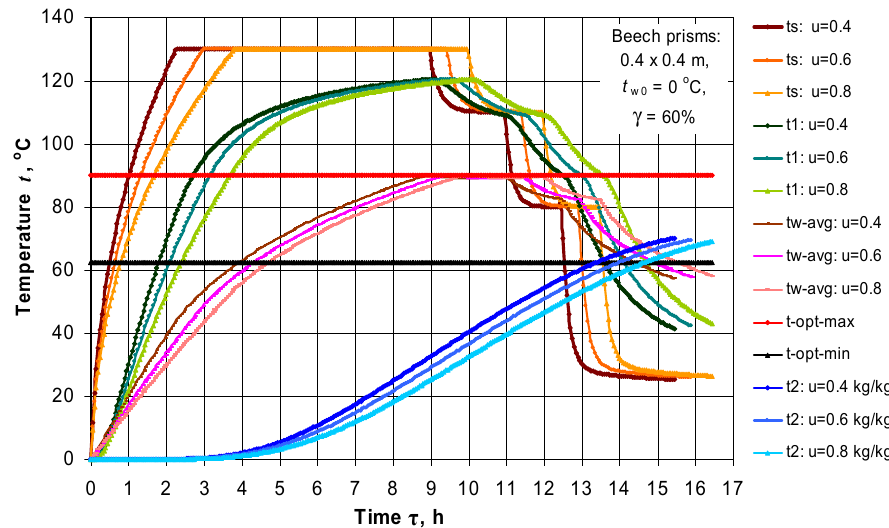
Figure 6. Changes in t s , t w-avg , and t in 2 characteristic points t 1 and t 2 of the prisms with d × b = 0.4 × 0.4 m and γ = 60% during their steaming in an autoclave and subsequent conditioning, depending on u and τ . The change in t s , t 1 , t 2 , and t w-avg during the steaming of prisms with intermediate values u = 0.6 kg · kg − 1 , and γ = 50%, and d × b = 0.3 × 0.3 m and d × b = 0.5 × 0.5 m is shown in Figures 7 and 8, respectively.